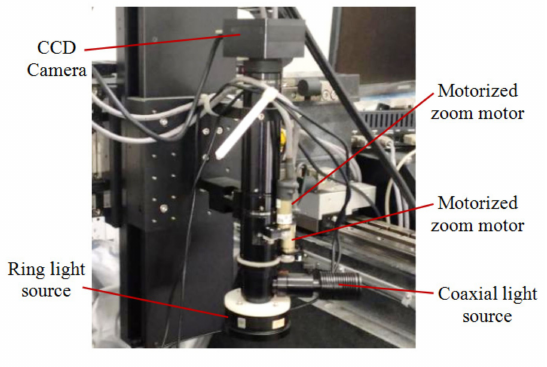
Figure 9. The machine vision measurement module setup for